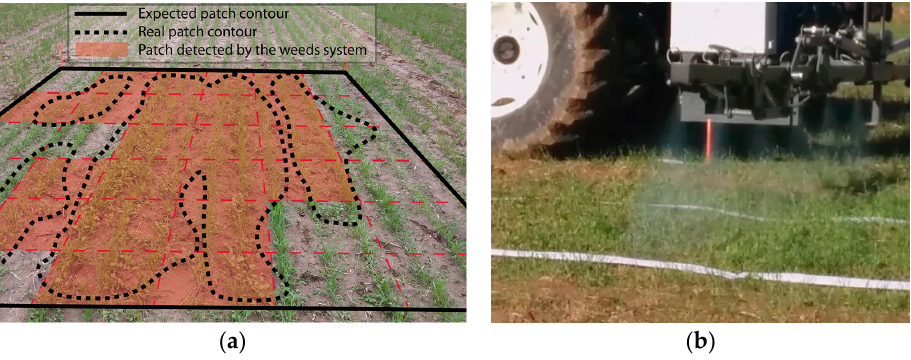
Figure 10. ( a ) Actual weed patch vs. expected weed patch and ( b ) paper strips along crop.